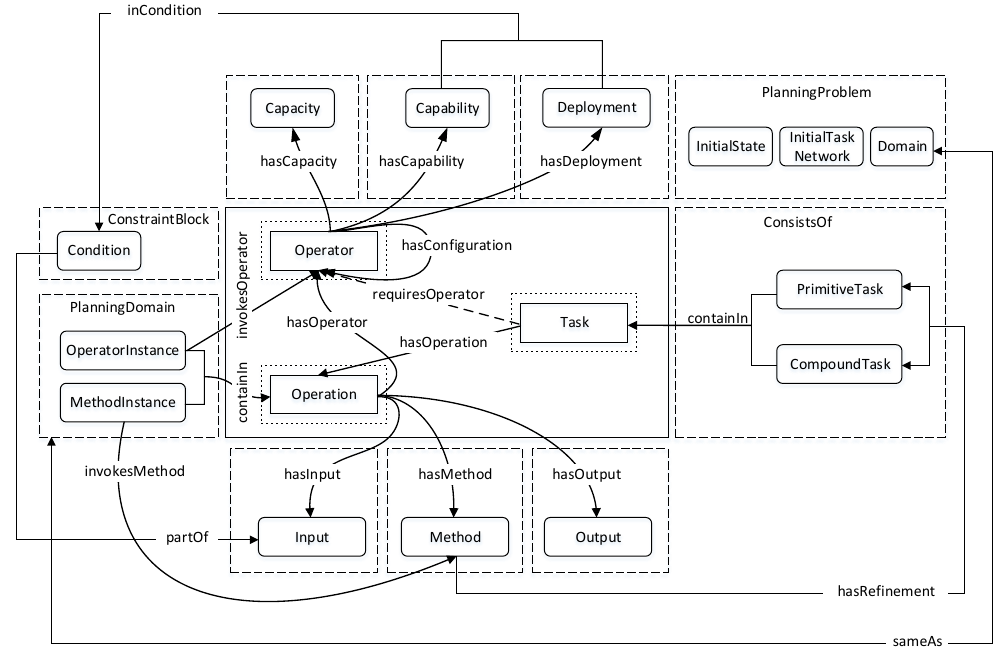
Figure 2. Hierarchical semantic task